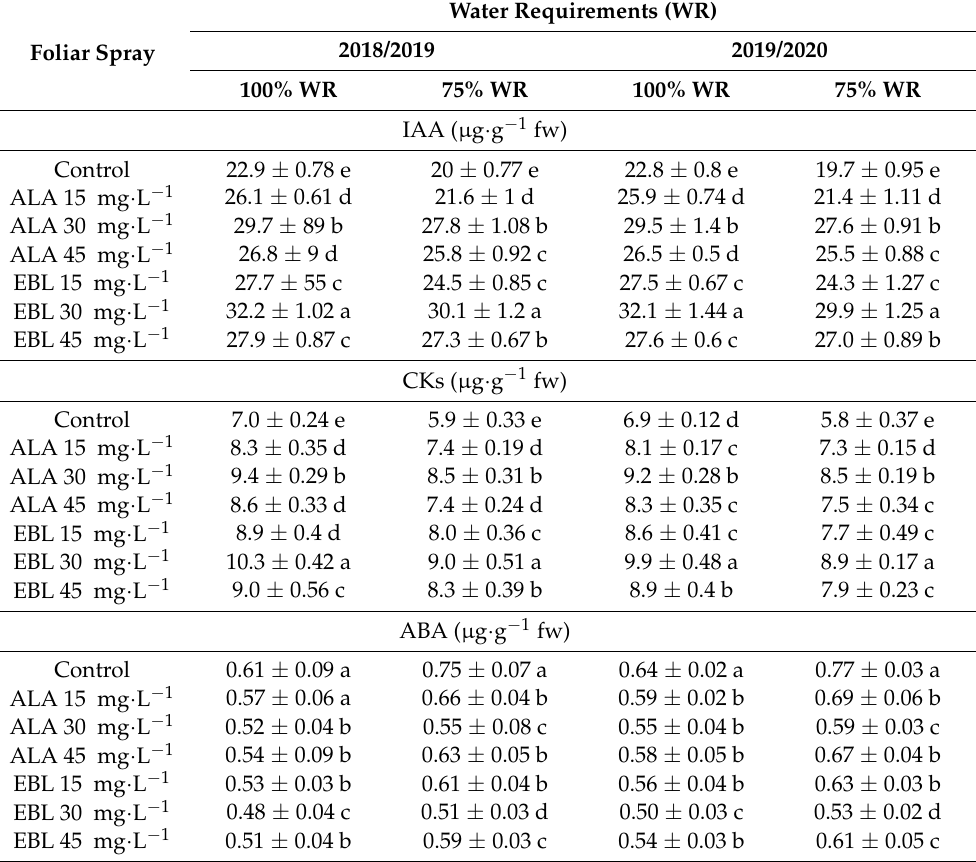
Table 2. Effect of foliar spray with ALA or EBL on the auxin (IAA), cytokinins (CKs), and abscisic acid (ABA) contents in drought-stressed “Williams” banana plants during the 2018/2019 and 2019/2020 seasons ( n =